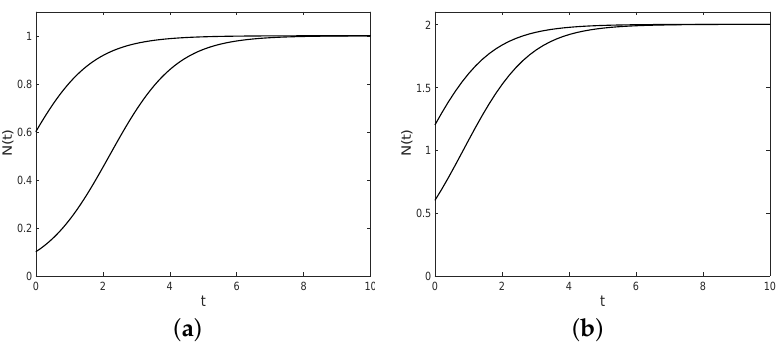
Figure 2. The logistic function N ( t ) with r = 1, ( a ): C = 1, y = 0.1 (bottom) and y = 0.6 (top); ( b ): C = 2, y = 0.6 (bottom) and y = 1.2